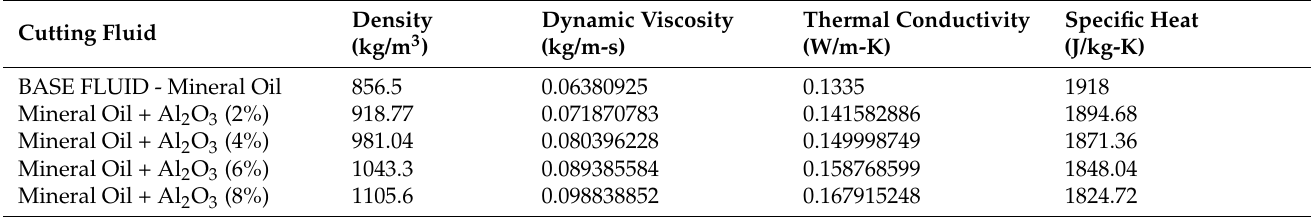
Table 2. Thermophysical and mechanical properties of mineral oil dispersed with Al 2 O 3 .